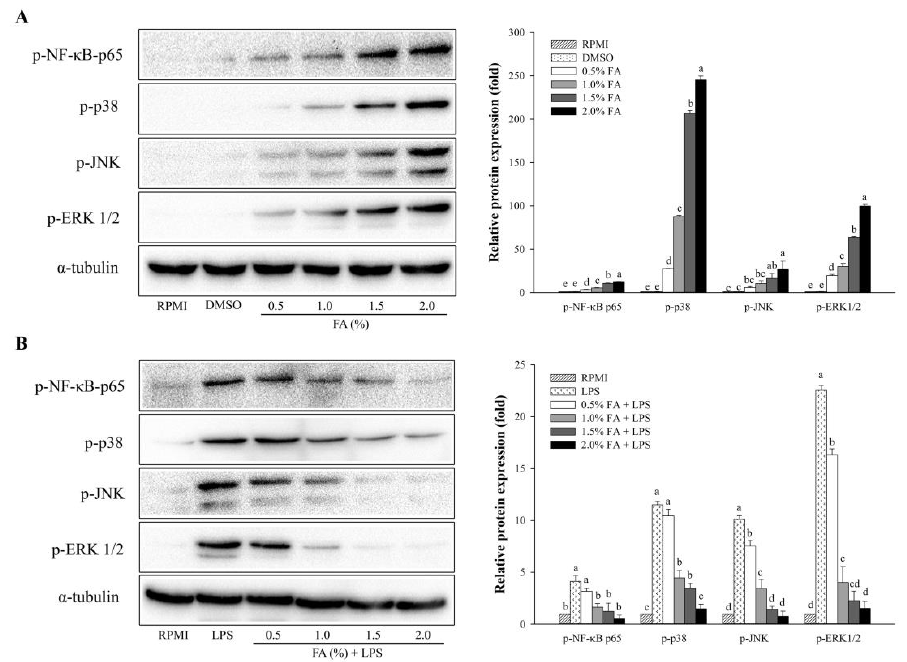
Figure 4. The effect of HAGF on NF- κ B and MAPK activation. ( A ) RAW264.7 cell protein expression. ( B ) Protein expression in RAW264.7 cells stimulated with LPS. Values are shown as means ± SD ( n = 3). Different letters (a–e) are used to reflect statistical differences at p < 0.05. FA = fatty